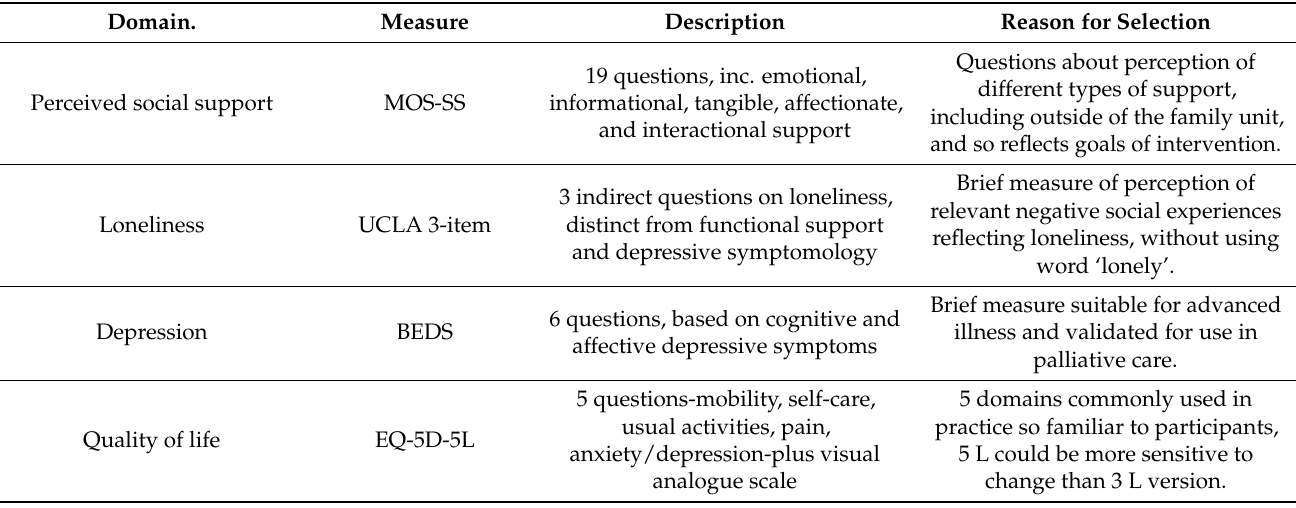
Table 2. Patient reported outcome measures used and